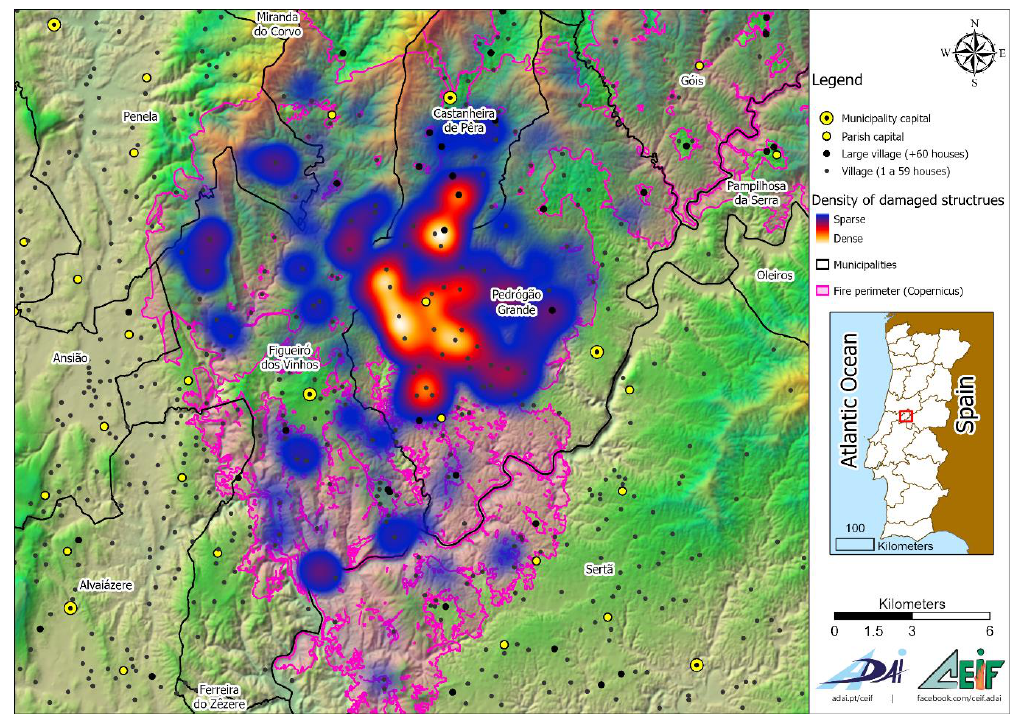
Figure 4. Heatmap representing the density of structures damaged by the fire.